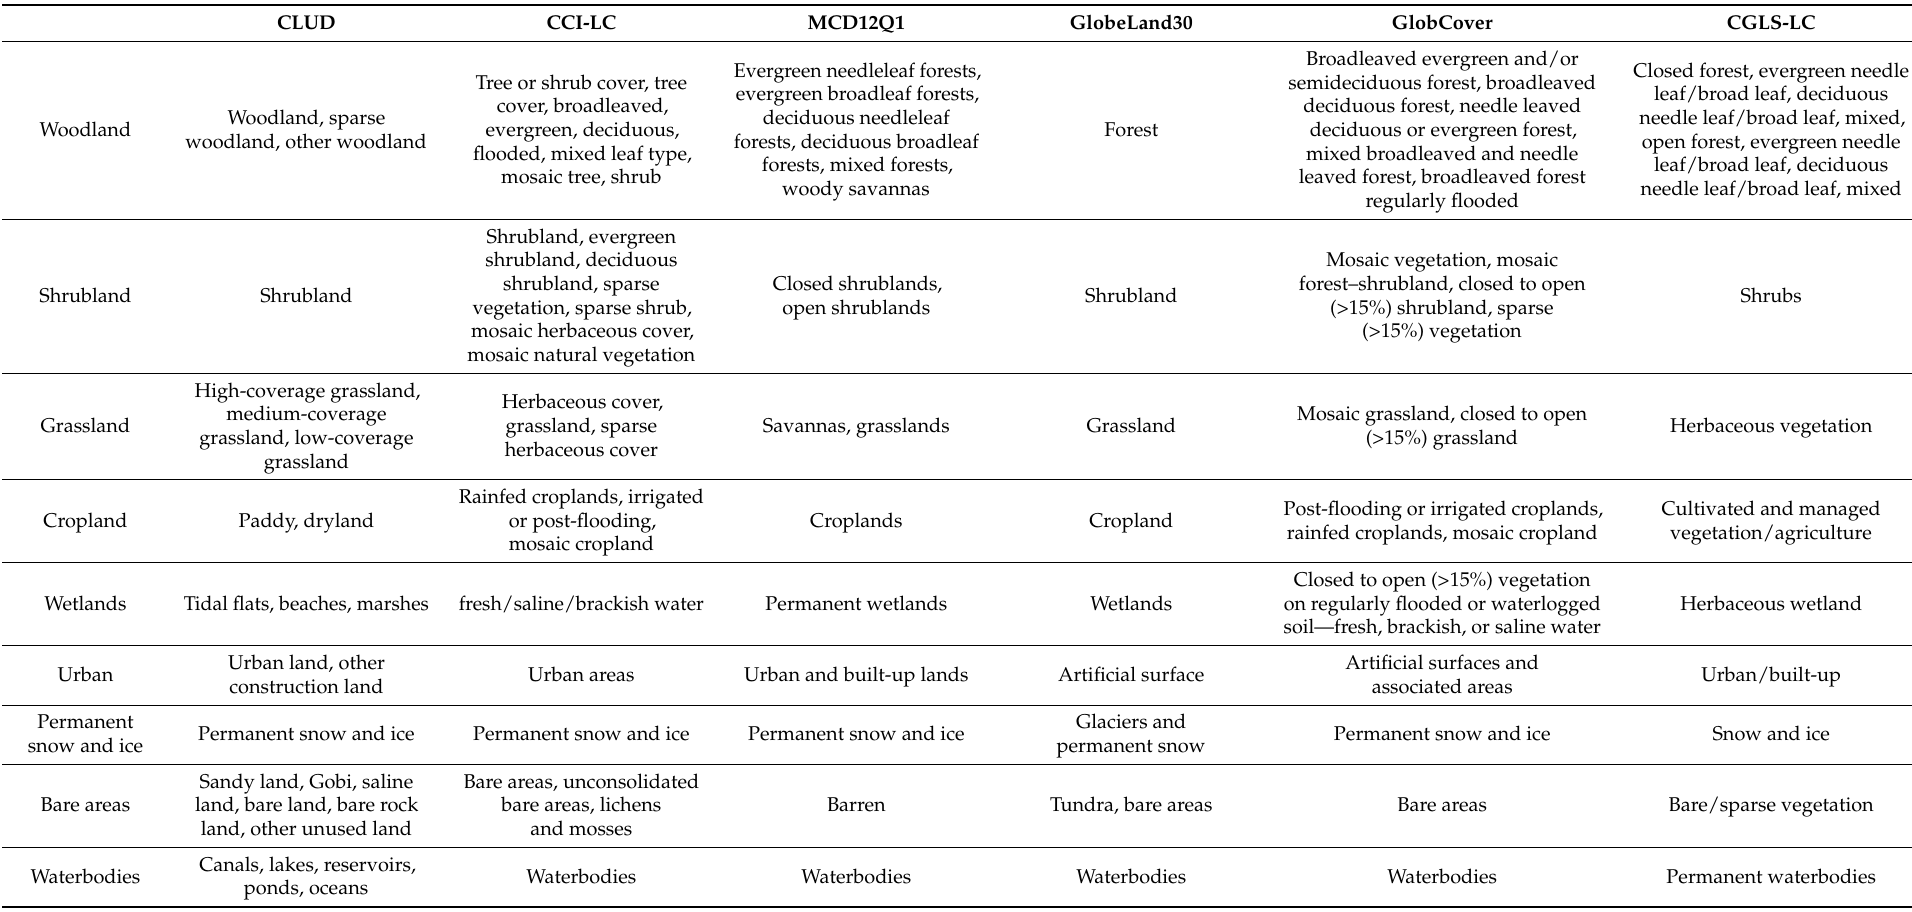
Table 2. Reclassification schemes employed in the six LC